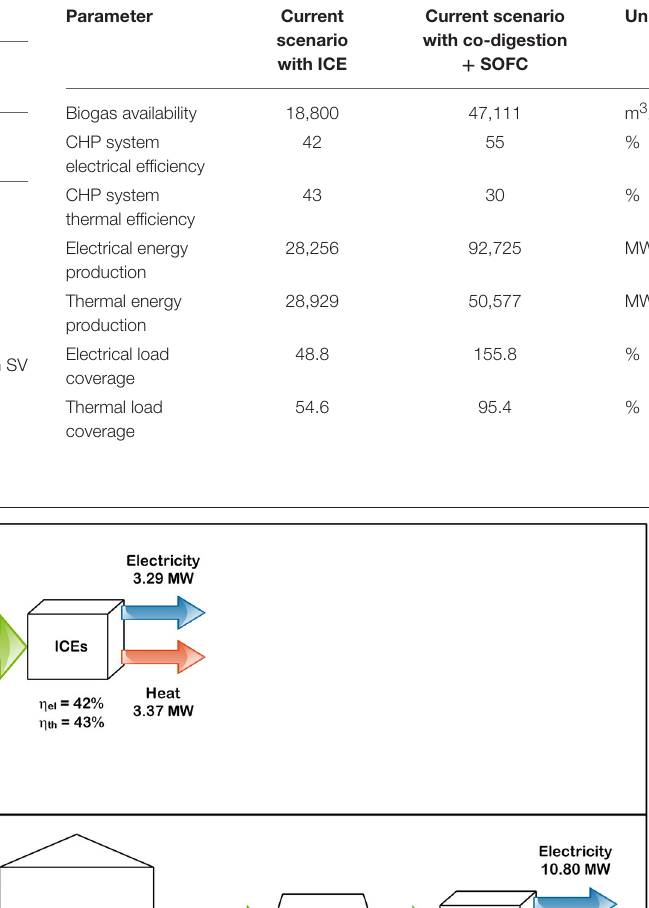
TABLE 10 | Energy balance comparison between the current scenario and the co-digestion scenario with biogas exploitation in SOFC.